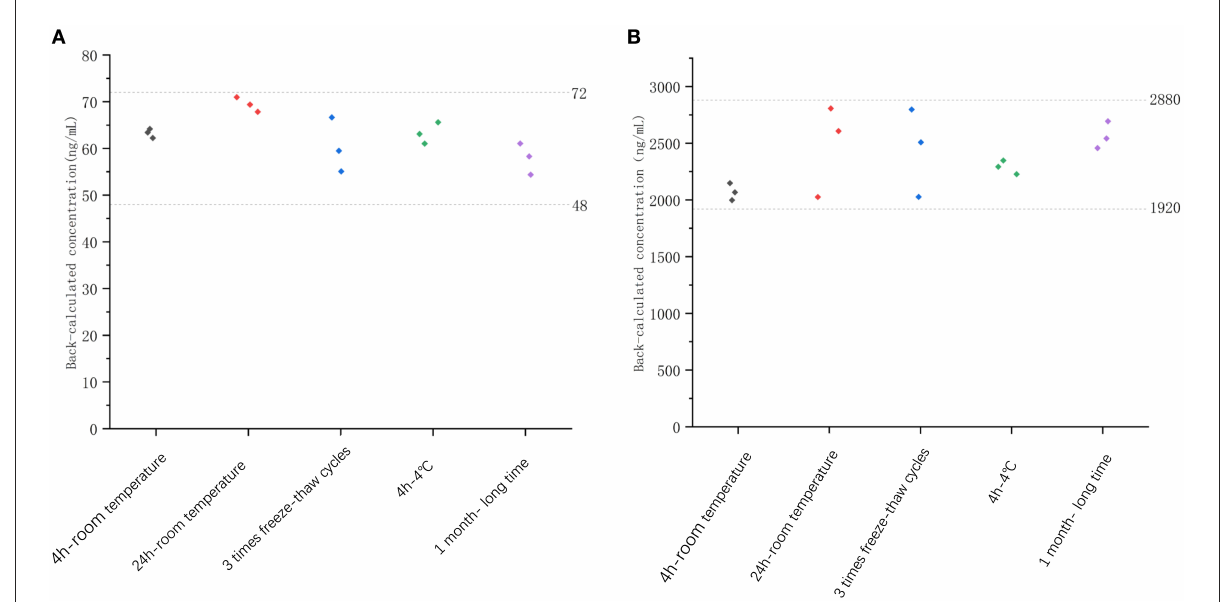
FIGURE4 The stability evaluation of recombinant canine PD-1 fusion protein determination under different conditions with low QC concentration (60ng/ml, A ) and high QC concentration (2,400ng/ml, B ).